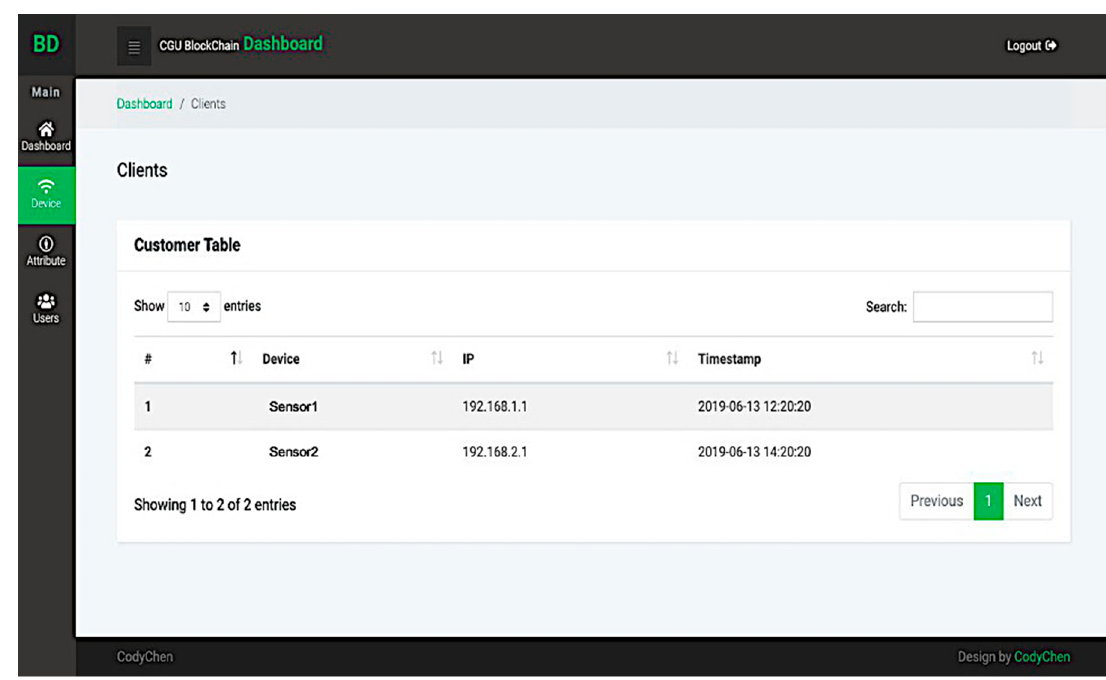
Figure 15. Table of registered devices.